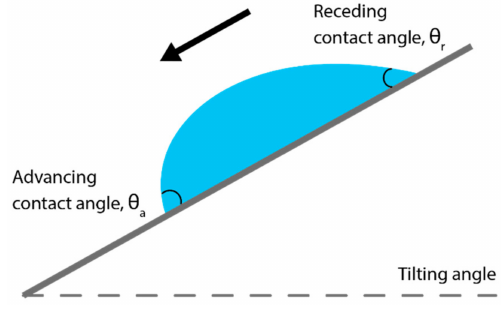
Figure 4. Illustration of the di ff erent angles formed by a droplet on a